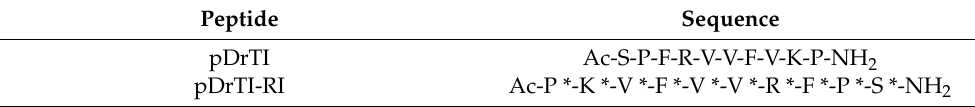
Table 1. Peptides